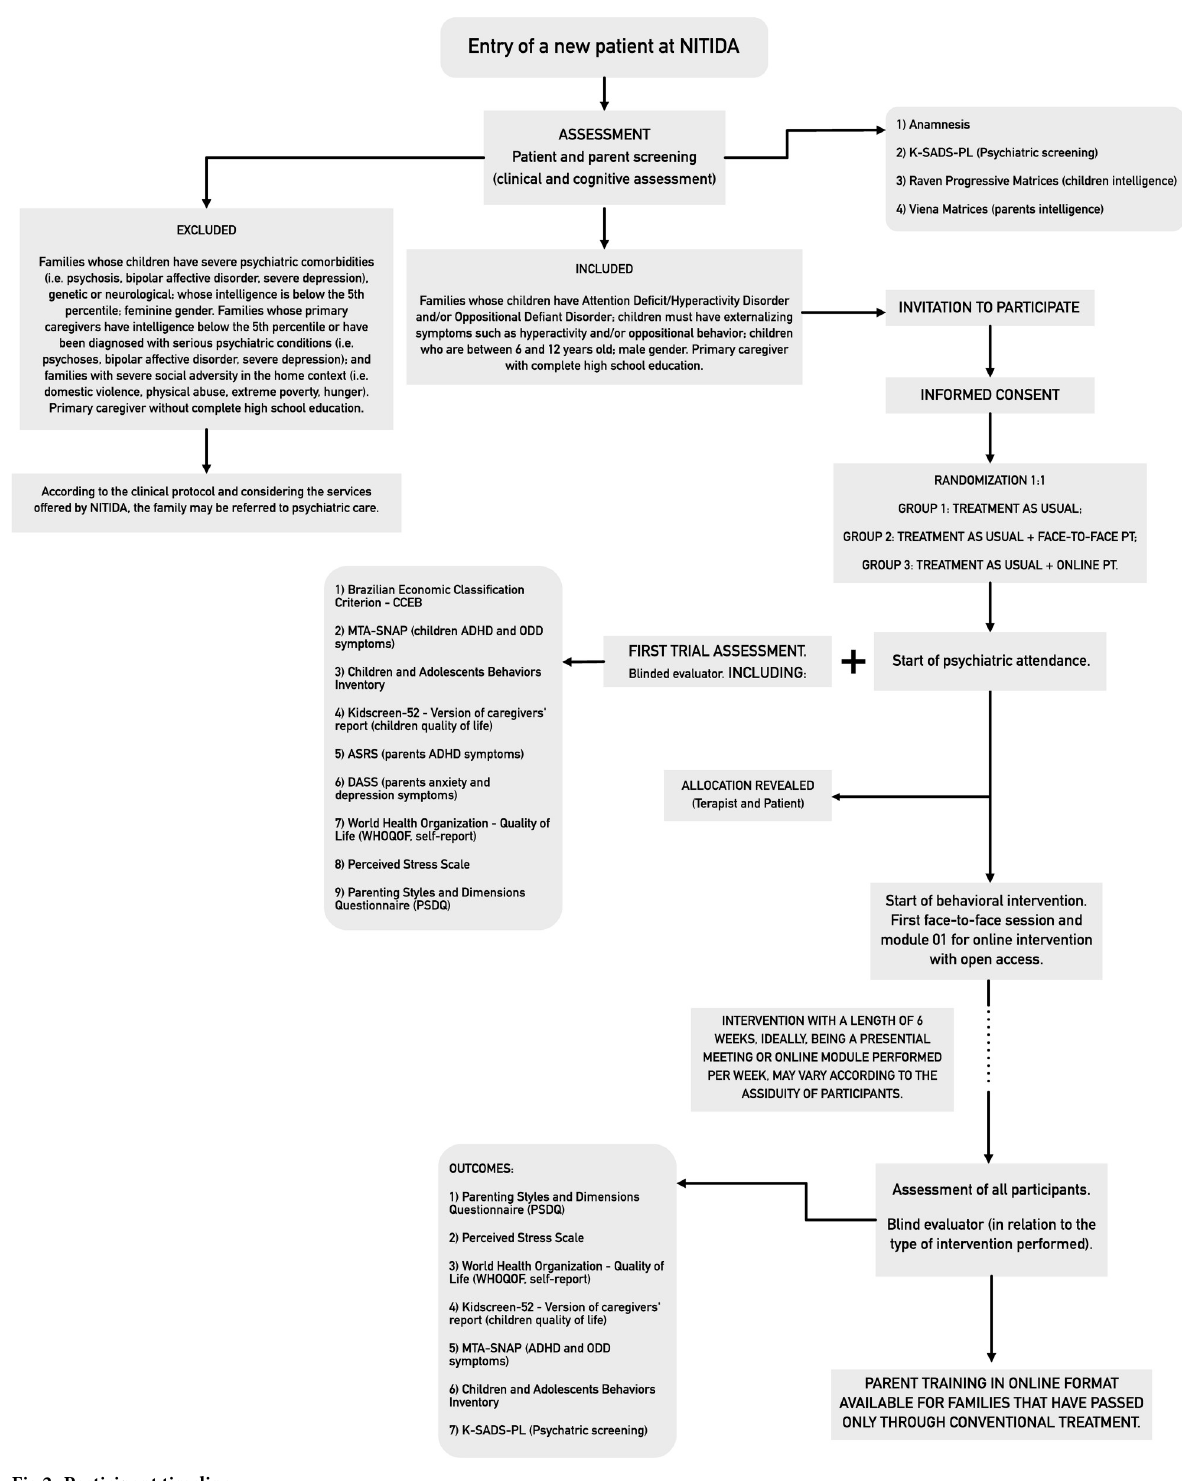
Fig 2. Participant timeline.